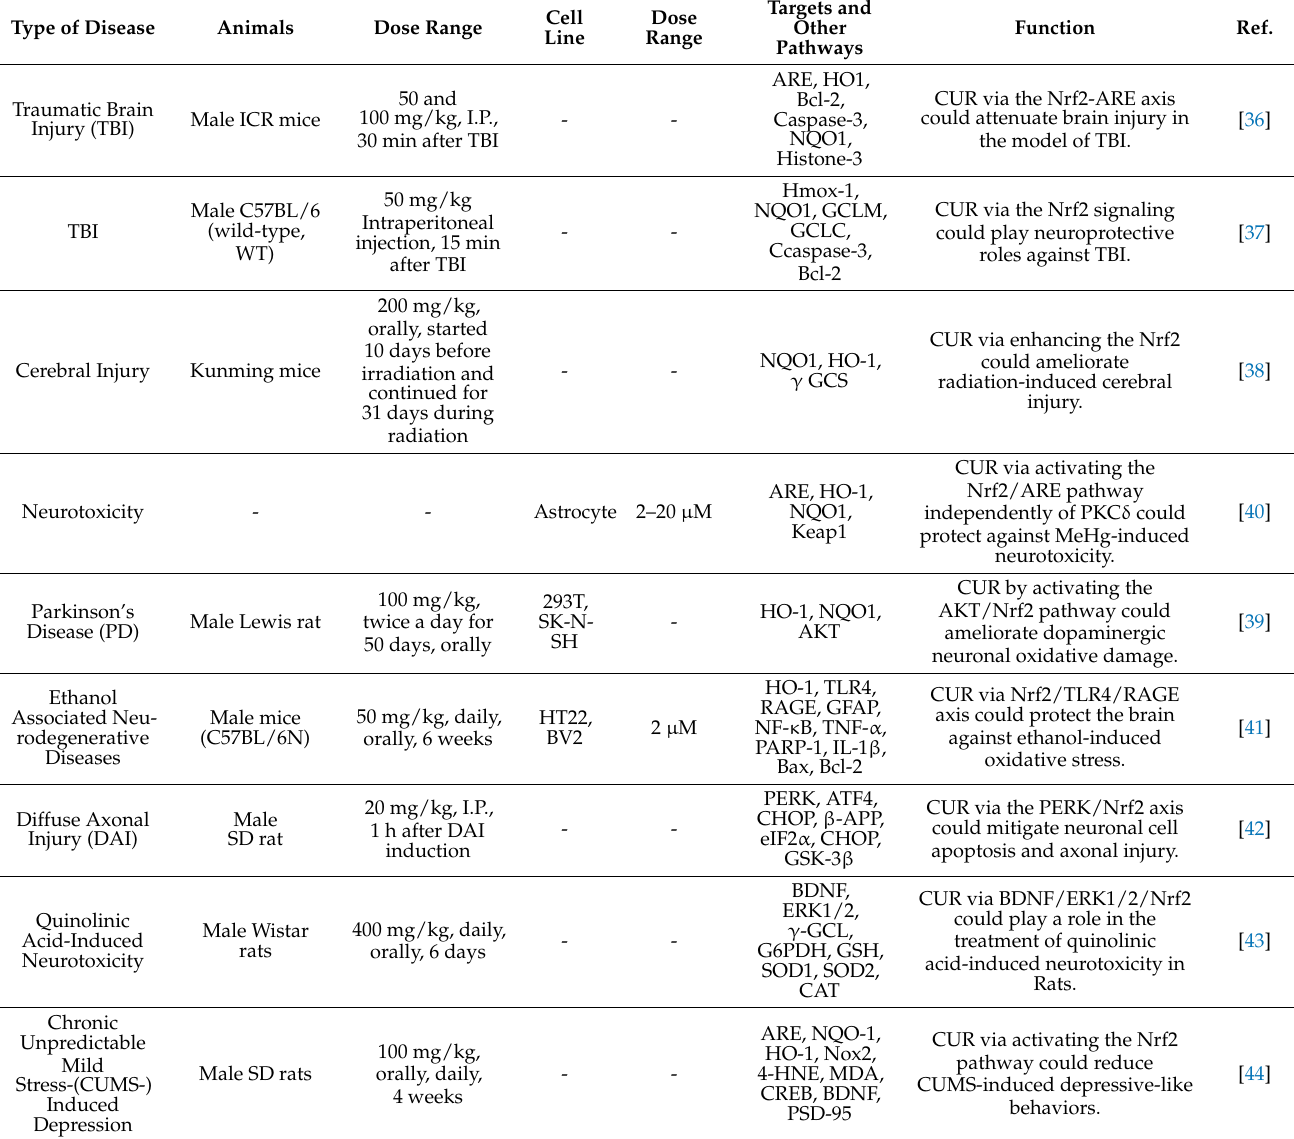
Table 4. Nrf2-related therapeutic effects of curcumin in nervous system